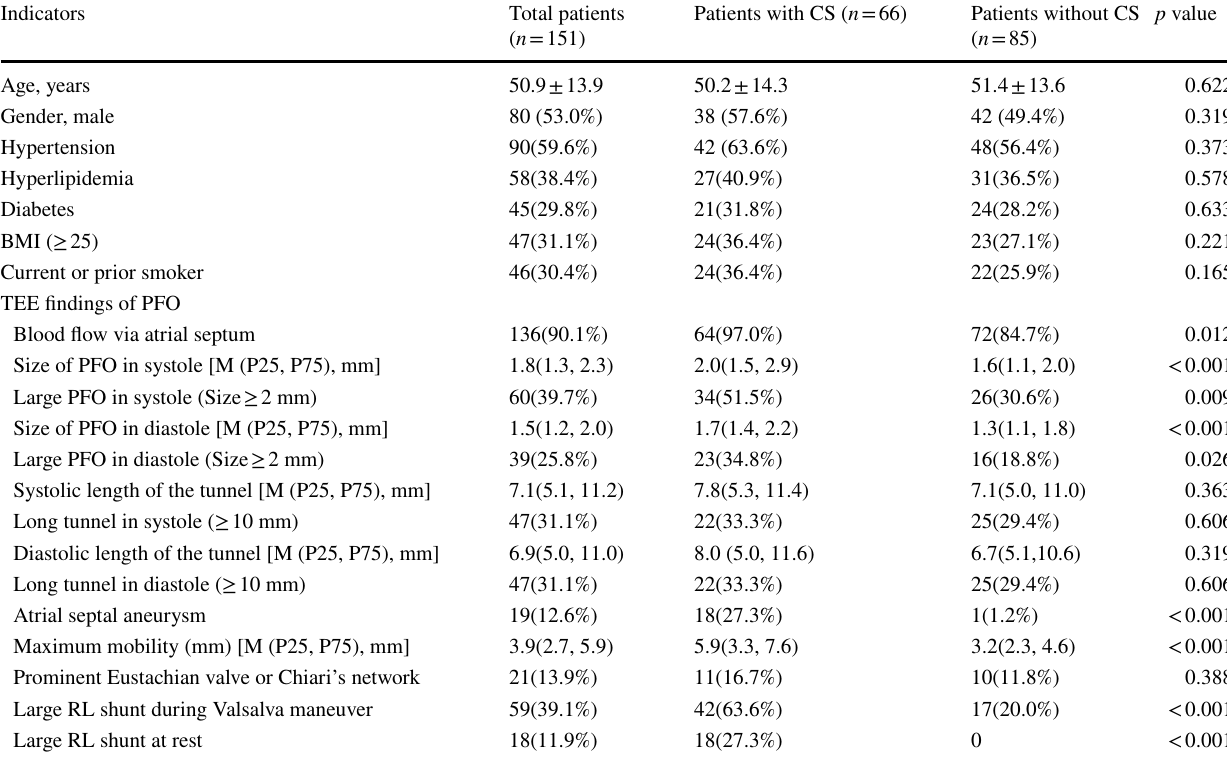
Table 1 Comparison of basic information between CS and non-CS groups Indicators Total patients